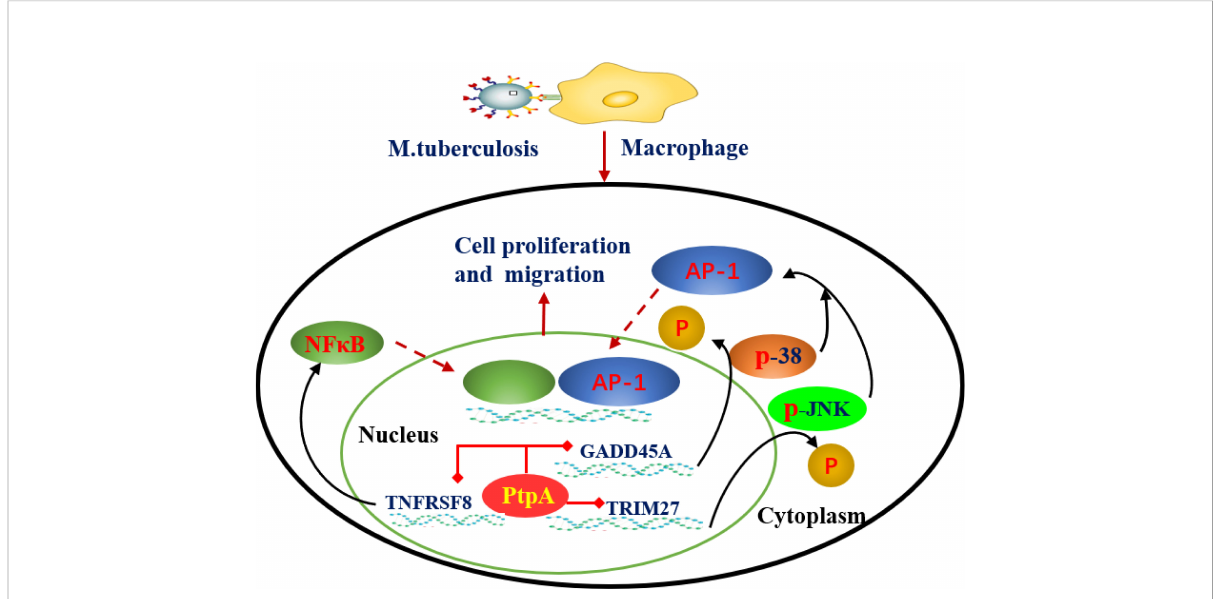
FIGURE 3 Mechanism by which MTB-PtpA enters the host cell nucleus to inhibit natural immune function. MTB PtpA is secreted into the host cell to bind ubiquitin molecules and is activated, and activated PtpA can inhibit the transcription of TNFRSF8 in the host nucleus, thus inhibiting the NF- k B signaling pathway. PtpA can also bind directly to the promoter region of the GADD45A or RNF187 gene and inhibit its transcription, dephosphorylating p-JNK and p-p38 to inhibit the activation of the JNK/p38 signaling pathway. (TNFRSF8, a member of the TNF-receptor superfamily; Trim27, belonging to E3 ubiquitin ligase family, can activate JNK/p38 signal pathway of host cells in a ubiquitin ligase activity dependent manner; GADD45A, a regulator of p38 MAPKs by inhibiting p38 phosphorylation and